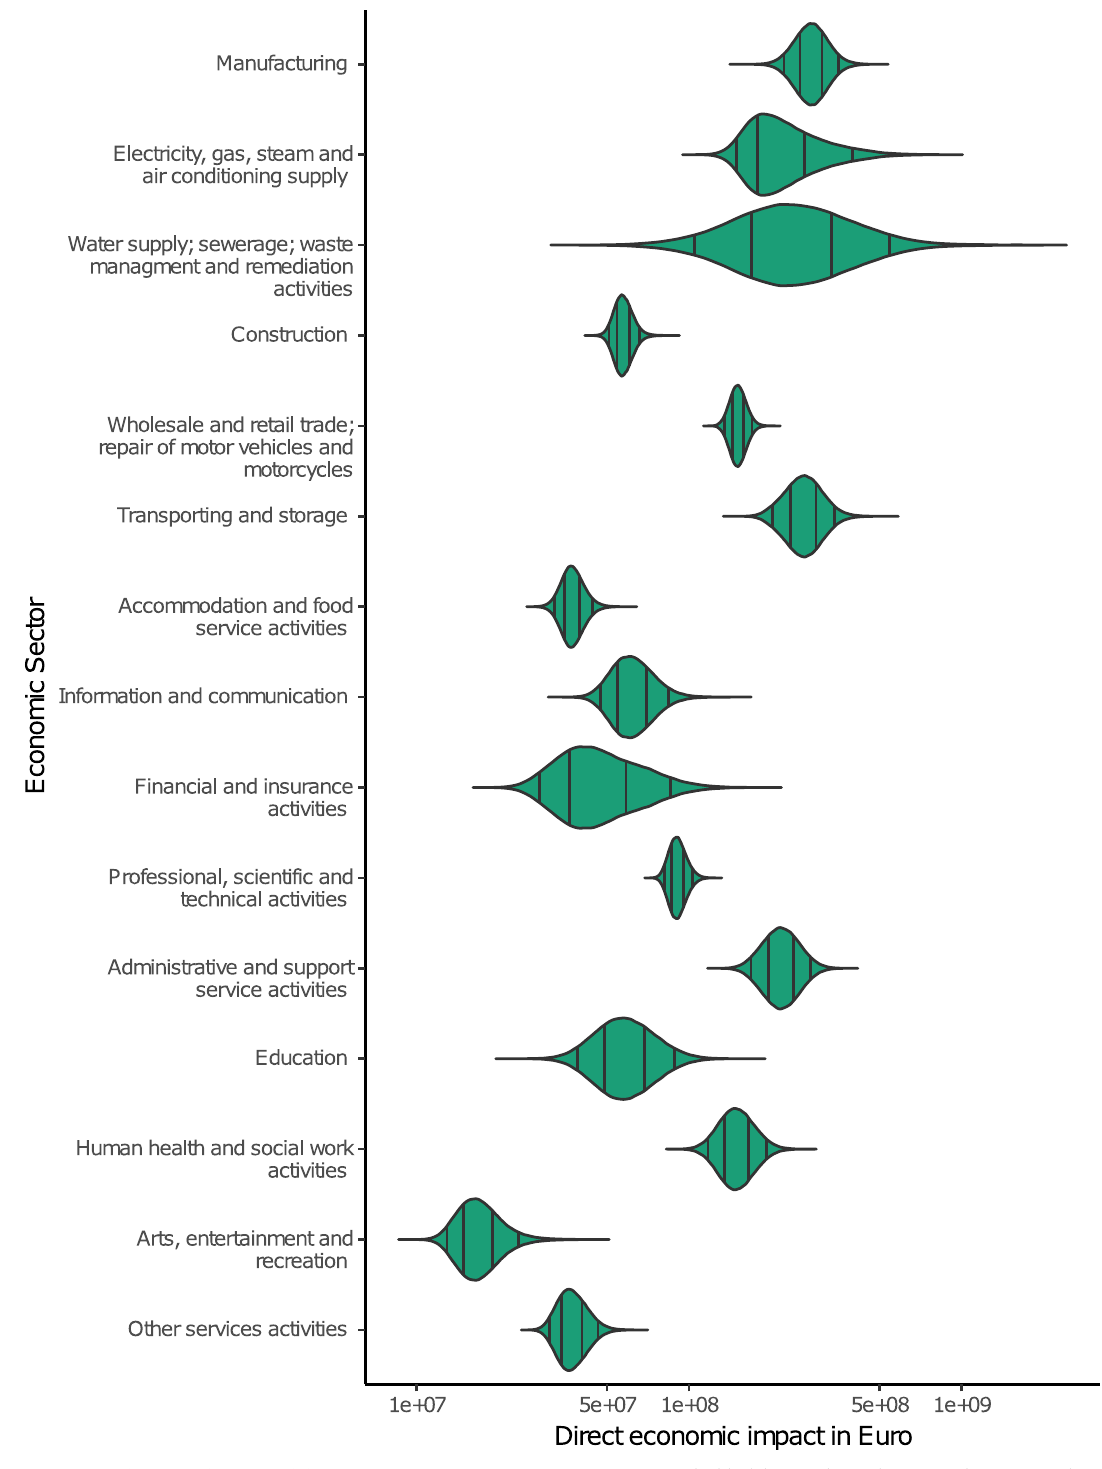
PLOS ONE | https://doi.org/10.1371/journal.pone.0212932 April 4,